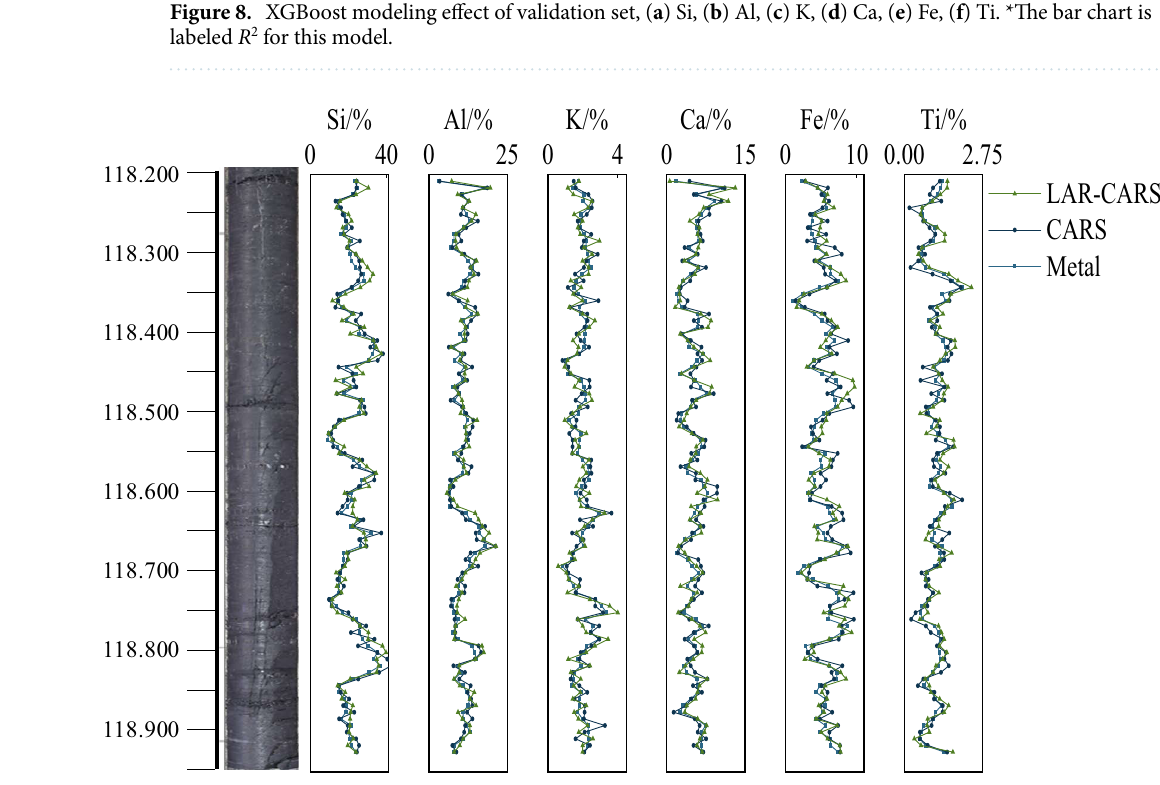
Figure 9. The effect of in-situ core